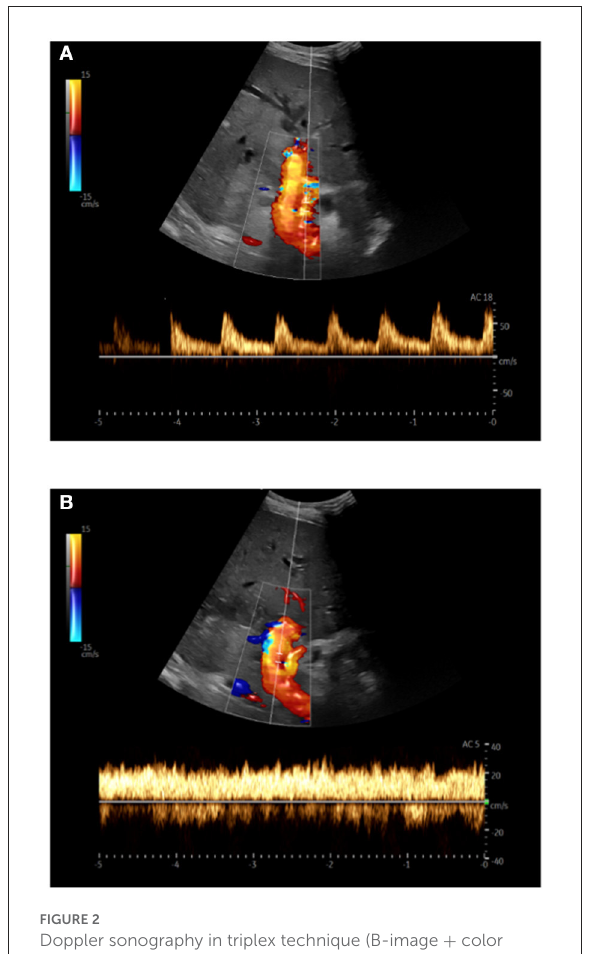
FIGURE2 Doppler sonography in triplex technique (B-image + color Doppler + spectral Doppler) in a patient with acute-on-chronic liver failure; (A) Hepatic artery: Derivation of the arterial flow signal; (B) Portal vein: The maximum flow velocity was measured at the level of the hepatic artery after angle